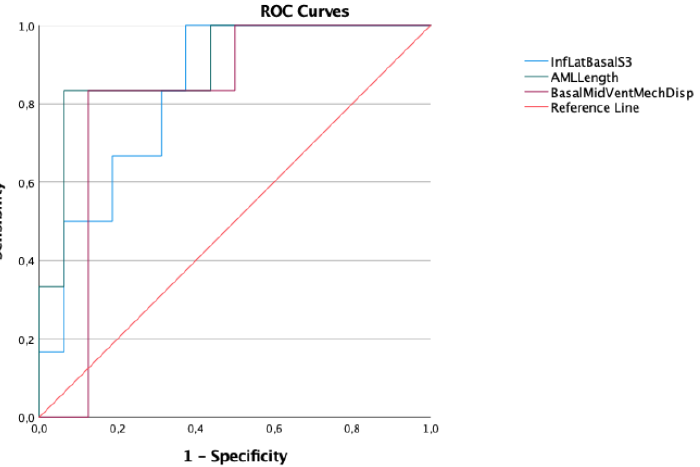
Figure 3. AML length, basal/mid-ventricular MD and inferolateral basal S3 ROC curves.